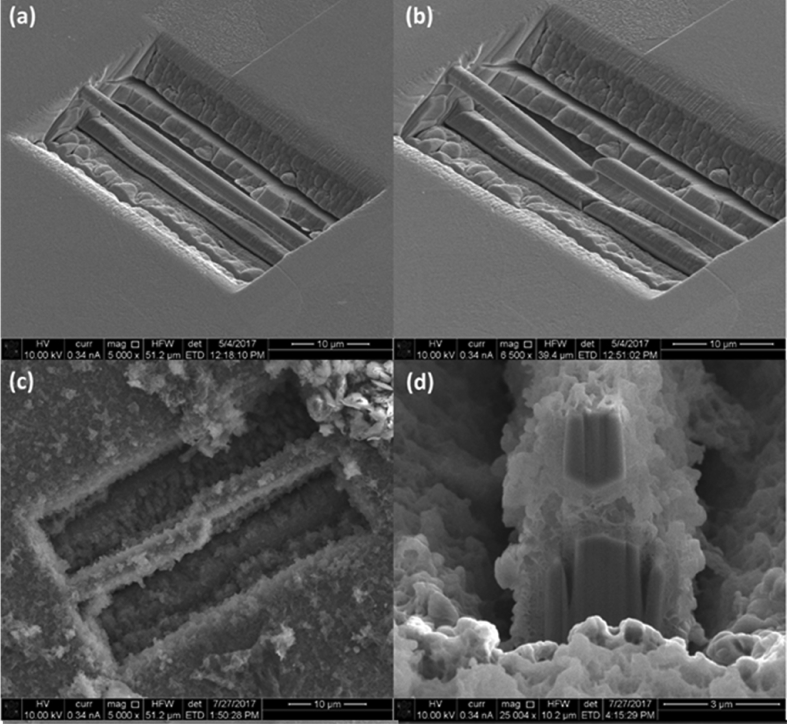
Example of a setup for EAC study on the micro length-scale in high-temperature, high-pressure water conditions: (a) hexagonal profile micro 40 μm length beam; (b) self-stressed micro-cantilevers; (c) top-down view of micro-cantilevers following exposure to how water environment; (d) cross-section of the corroded hexagonal beam following exposure to hot water environment. From Holmes et al. [2018].47